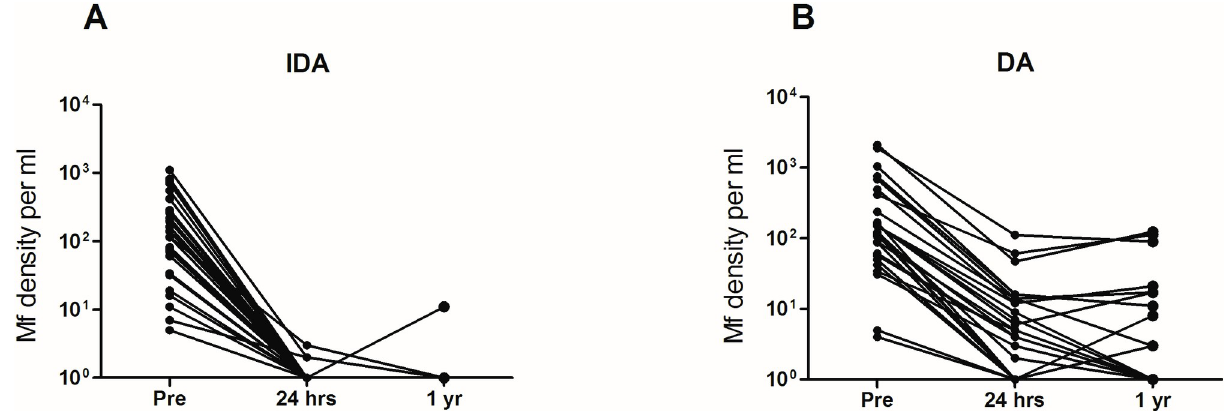
Fig 2. Reductions in B . timori microfilaria (Mf) density 24 h and one year after treatment with ivermectin plus diethylcarbamazine and albendazole (IDA) (panel A) or diethylcarbamazine plus albendazole (DA) (panel B).